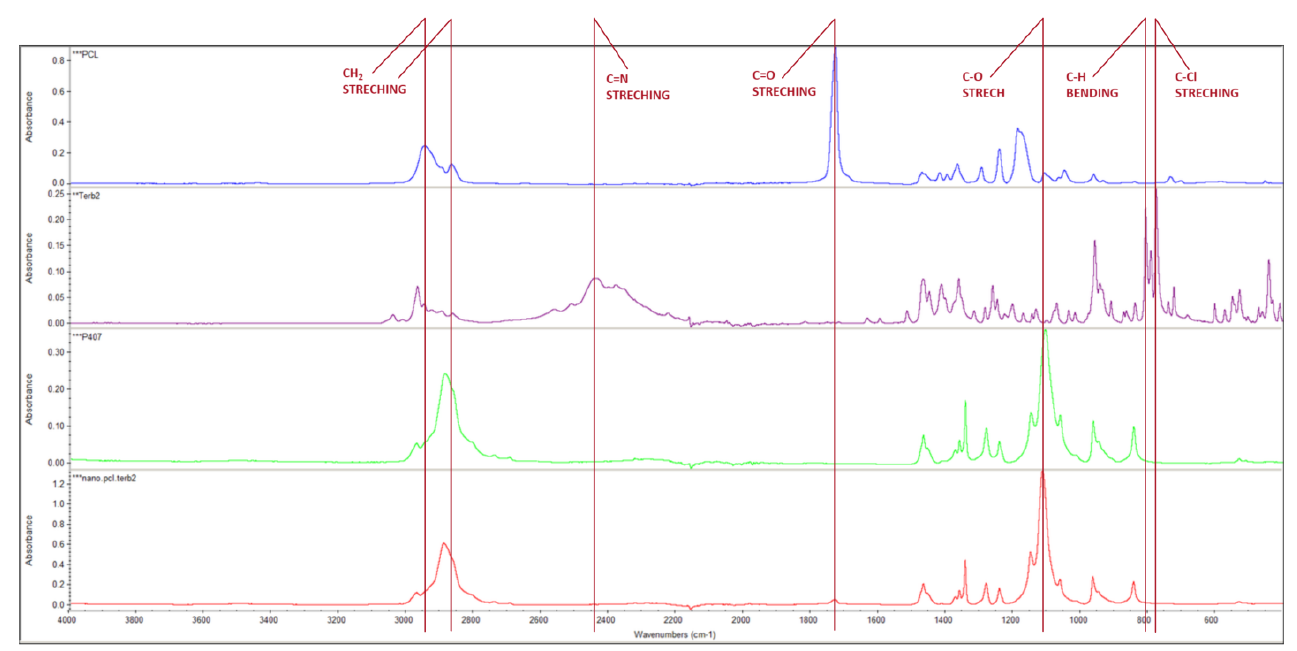
Figure 3. ATR-FTIR spectra of PCL, Terbinafine hydrochloride, P407, and the nanoparticle suspension with terbinafine, respectively.